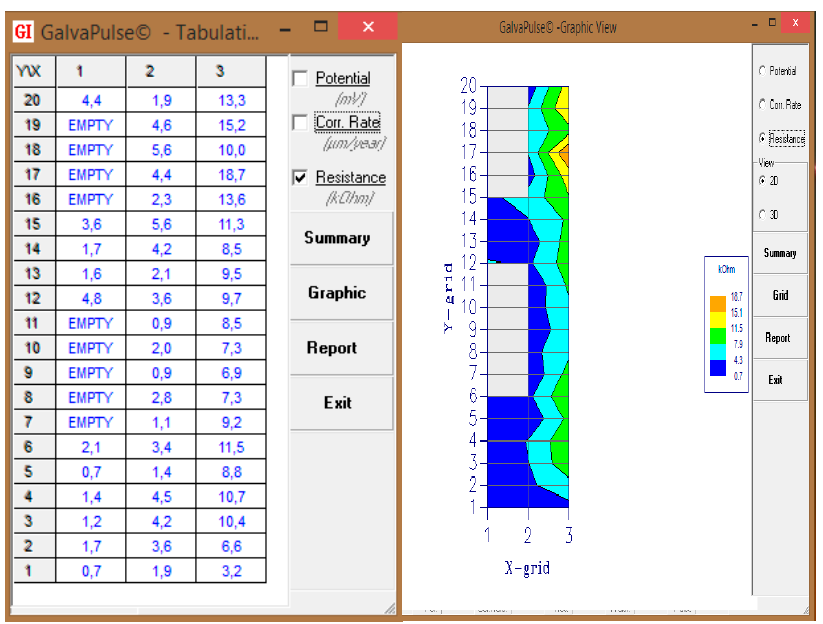
Figure 7. The results of concrete cover resistivity measurements.